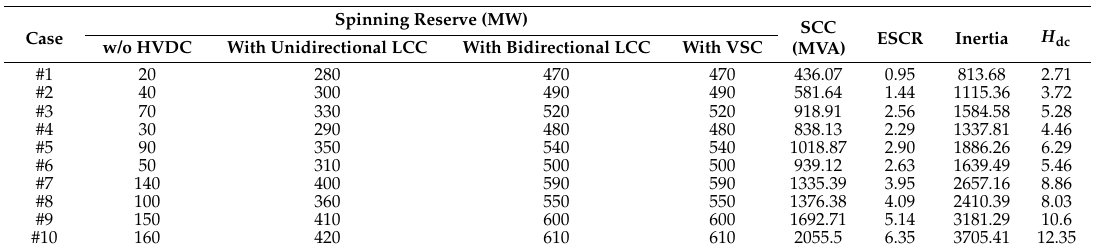
Table 4. System analysis results considering Jeju #1 HVDC transmission. Short circuit capacity: SCC; effective short circuit ratio: